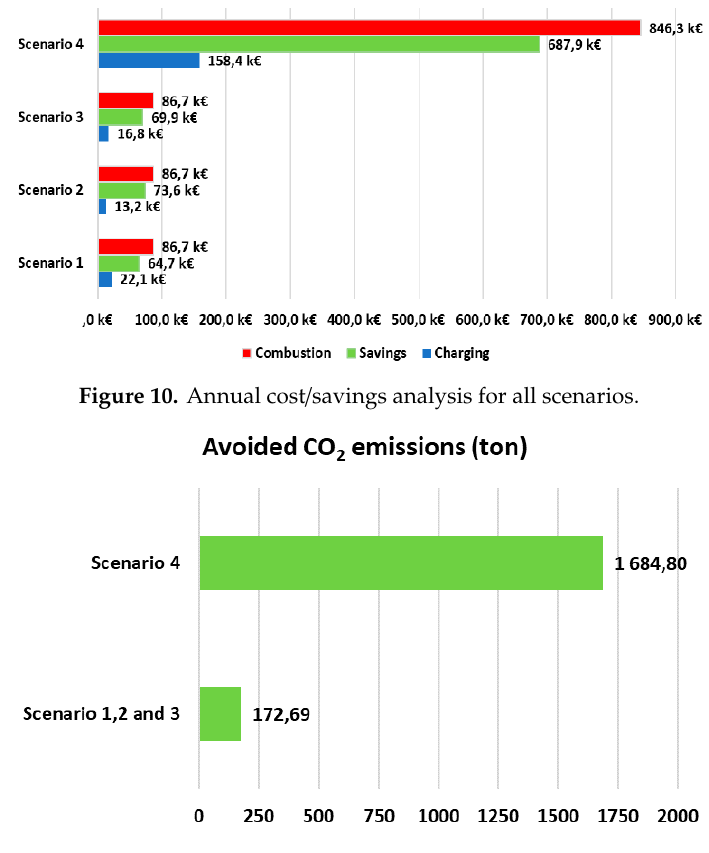
Figure 11. Annual avoided CO 2 emissions.